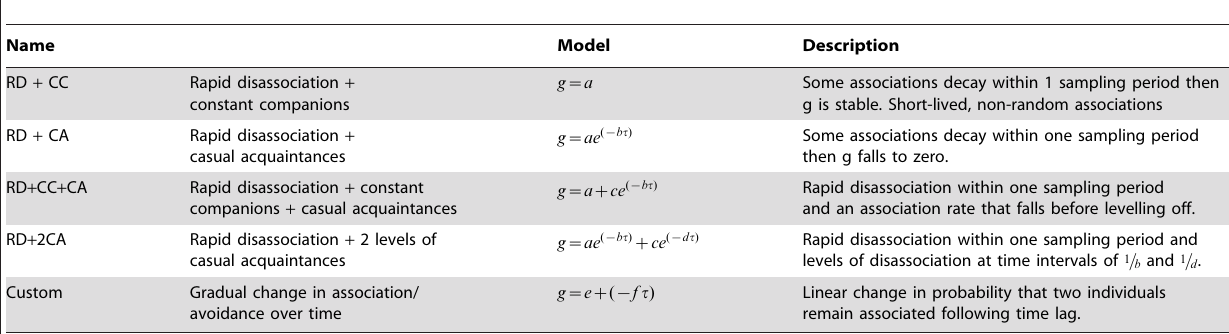
Table 1. Description of models fitted to lagged association rates (g) in Socprog 2.3. For time lags ( t ) of minutes, we chose four models (parameters: a, b, c, d ) that incorporated rapid periods of disassociation and selected the model of best fit according to the quasiliklihood Akaike Information criterion